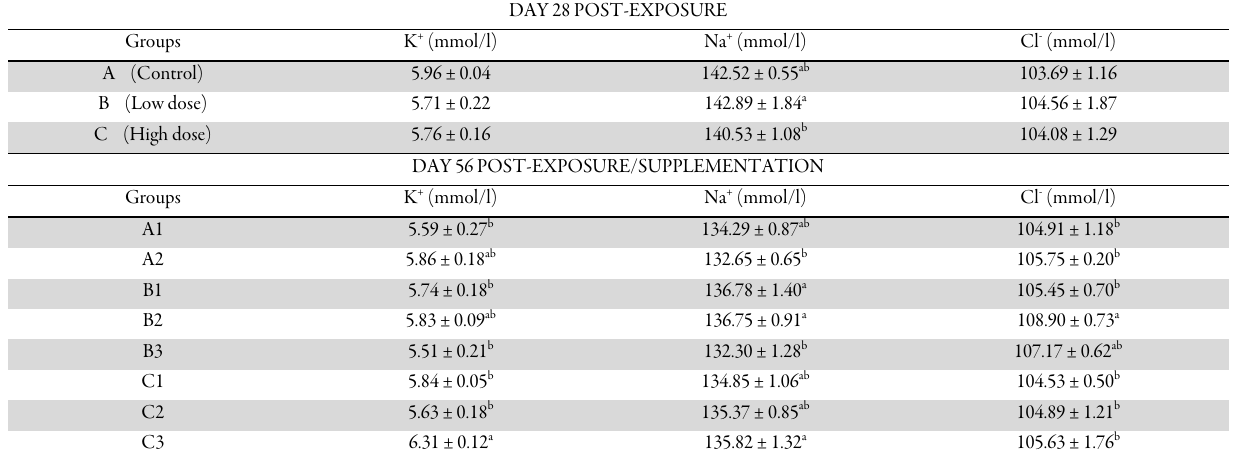
Table 3. Effects of Vitamin E supplementation on serum electrolytes in male rats with crude oil-induced